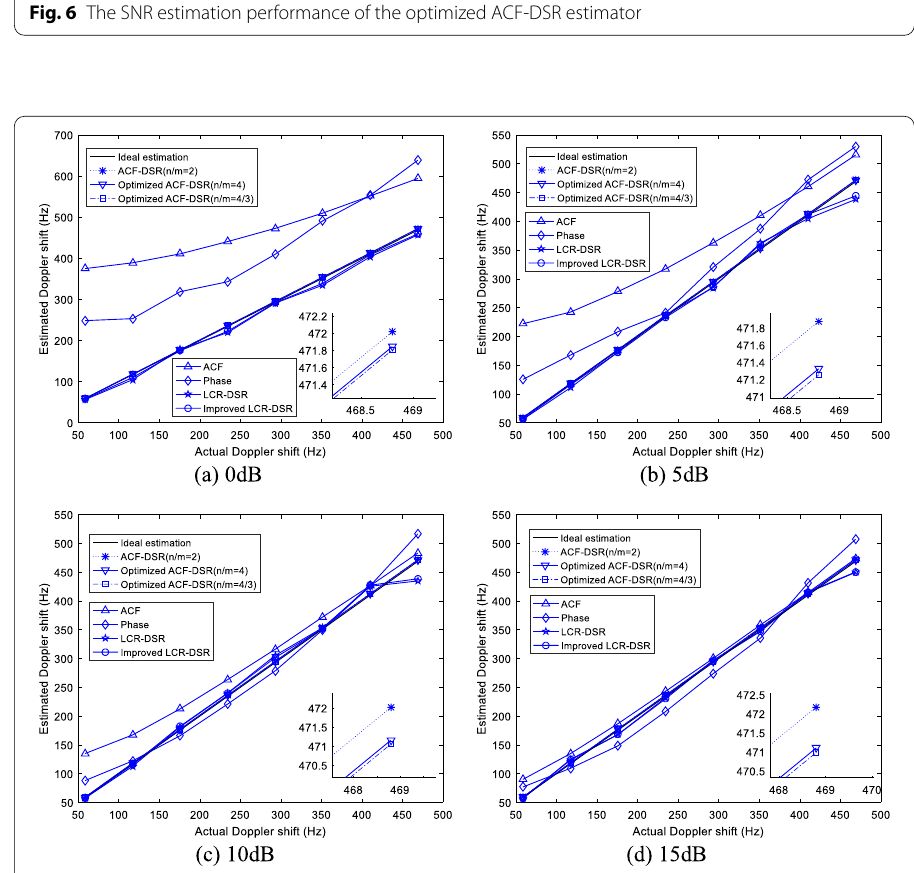
Fig. 7 The Doppler shift estimation comparison of the optimized ACF-DSR method and previous